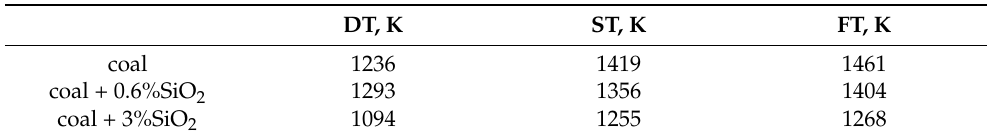
Figure 5. Micromorphology of the PM (stages 7 ( a ) and 11 ( b )) generated from the combustion of coal WX + 0.6%SiO 2 . Table 4. Melting behavior of the low-temperature ash of coal WX with different amounts of nano SiO2 additions.